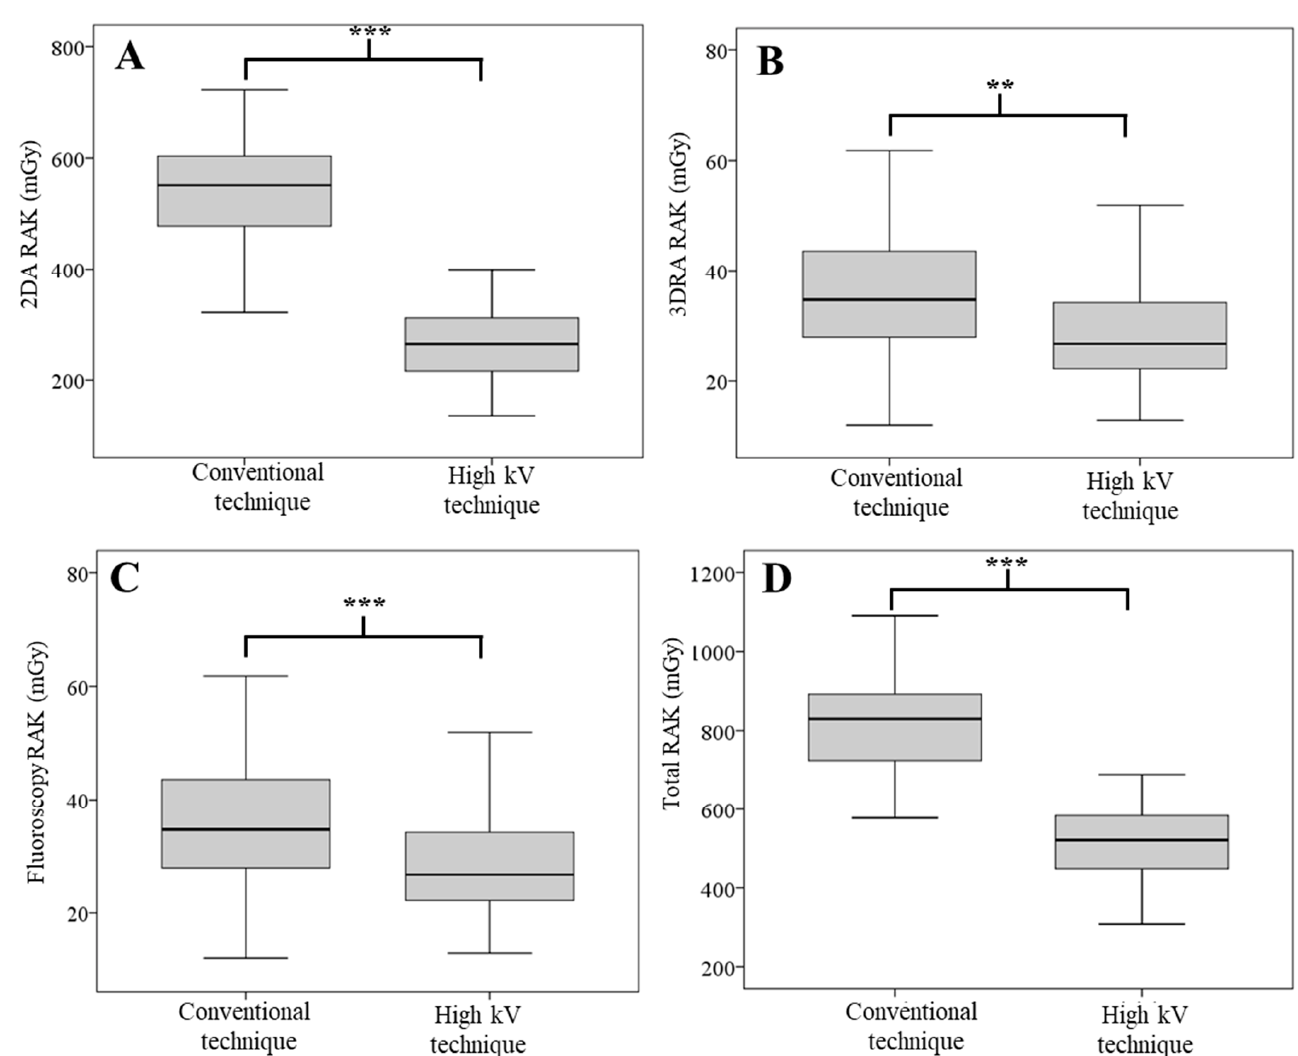
Figure 3. RAK from the 2DA technique ( A ), 3DRA technique ( B ), fluoroscopic technique ( C ), and Total RAK ( D ). ** and *** indicate significant differences with p -value < 0.01 and 0.001, respectively.